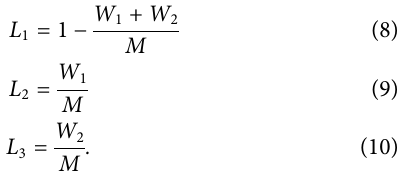
Table 1 . The total number of samples is M. The number of samples with microcracks is G. The number of undetected panel is W1. The number of missed detection panel is W2.